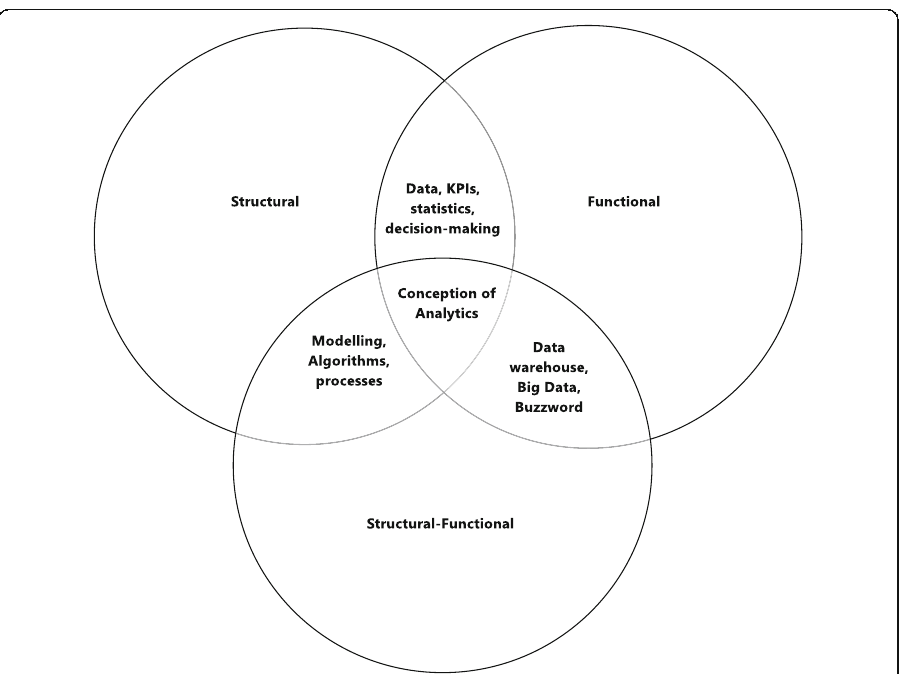
Fig. 4 Perceptions of analytics among